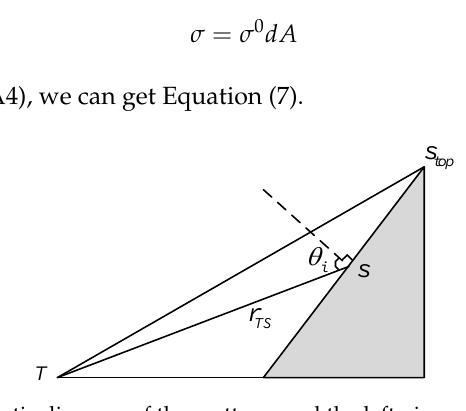
Figure A1. Schematic diagram of the scatterer and the left view of the scatterer slope.